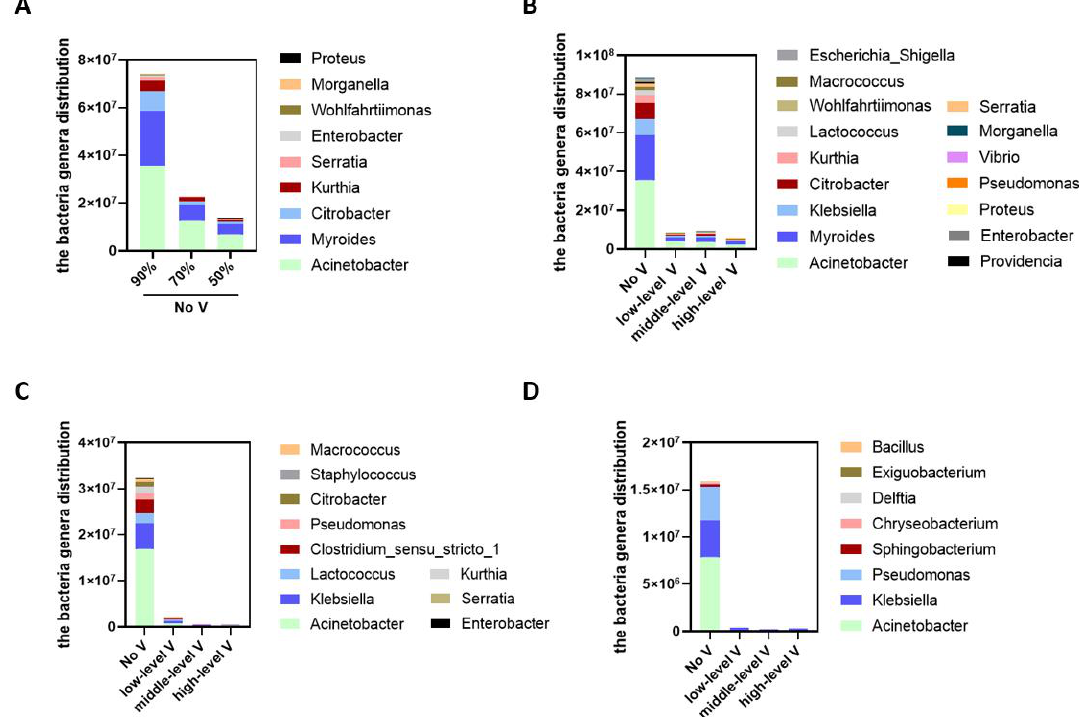
Figure 7. The effect of humidity and ventilation on the bacterial genera distribution at 26 °C. ( A ) The effect of different humidity levels (90%, 70%, 50%) on bacterial genera without ventilation; ( B ) the effect of ventilation on bacterial genera under 90% humidity; ( C ) the effect of ventilation on bacterial genera under 70% humidity; ( D ) the effect of ventilation on bacterial genera under 50% humidity.